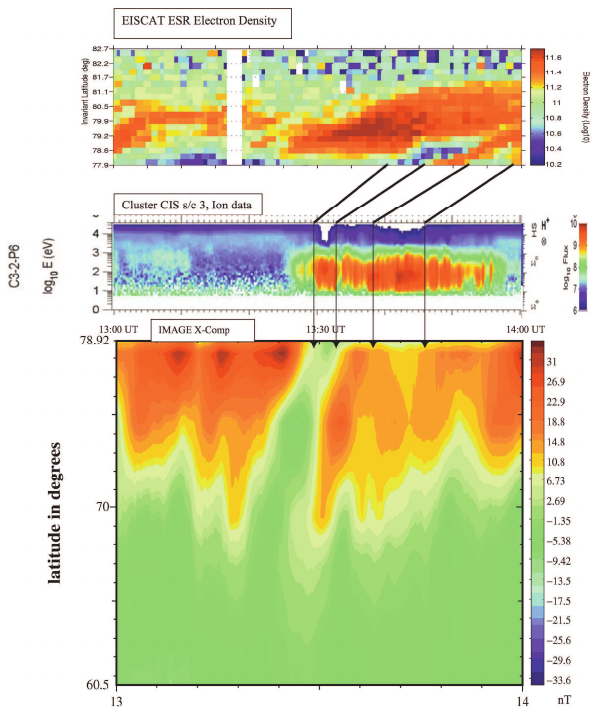
Fig. 9. Stacked plot showing the electron density observed along the northward-looking beam of the ESR (top panel), total ion flux from the CIS instrument on the Cluster 3 spacecraft (middle panel) and magnetic X-disturbance along the central meridian of the Scan- dinavian IMAGE magnetometer network (lower panel). The thin arrows show the relationship of features in the CIS data to regions of eastward (red) and westward (green) current flow as observed by the magnetometer network. The heavier black bars illustrate the possible continued polar propagation of these features towards the southernmost latitudes observed by the ESR. (From Opgenoorth et al.,